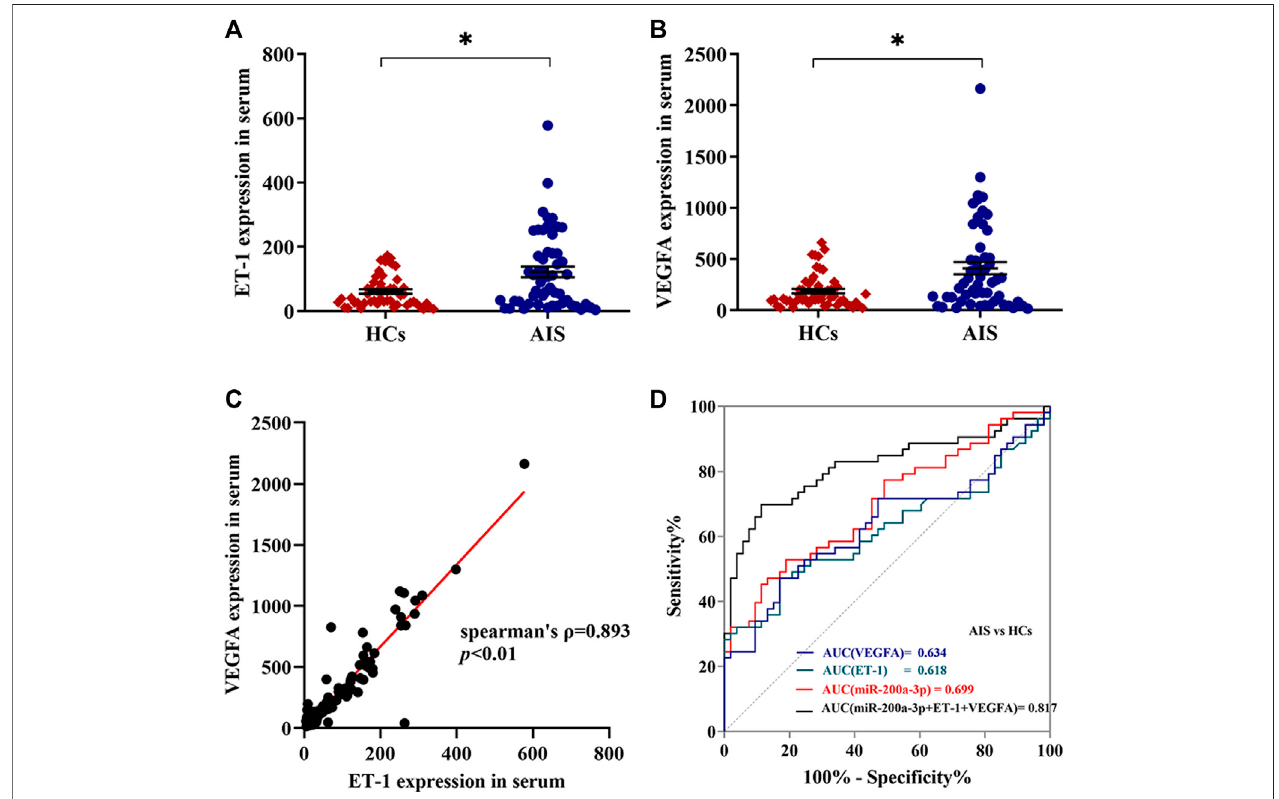
FIGURE4| ExpressionlevelsofET-1andVEGFAinserumofAISpatientsandhealthycontrols. (A,B) TheexpressionlevelsofET-1andVEGFAintheserumofAIS patients and HCs were detected by ELISA. (C) The correlation between ET-1 levels and VEGFA levels in serum was assessed by the Spearman ’ s rank correlation coef fi cient, n =106. (D) DiagnosticvalueofplateletmiR-200a-3p,serumET-1andVEGFAlevelsinAIS.ROCcurvesweregeneratedbasedonserumET-1levels,VEGFA levels,andthecombinationindexwithplateletmiR-200a-3ptodistinguishAISpatients( n =53)fromnormalcontrols( n =53).Datawereexpressedasmean±SEM. Differences between AIS patients and HCs were assessed by the Mann-Whitney U test, respectively, * p < 0.05.